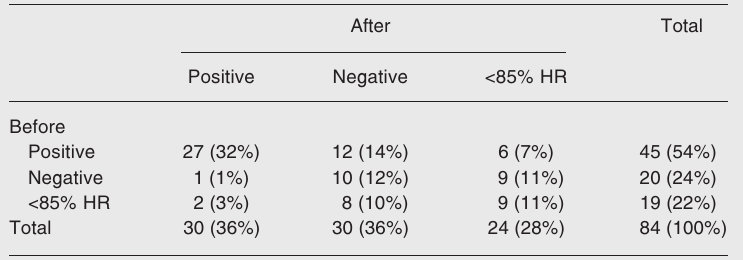
Table 2. Results of the exercise treadmill test before and after percutaneous coronary intervention (P = 0.014; McNemar test). After Total